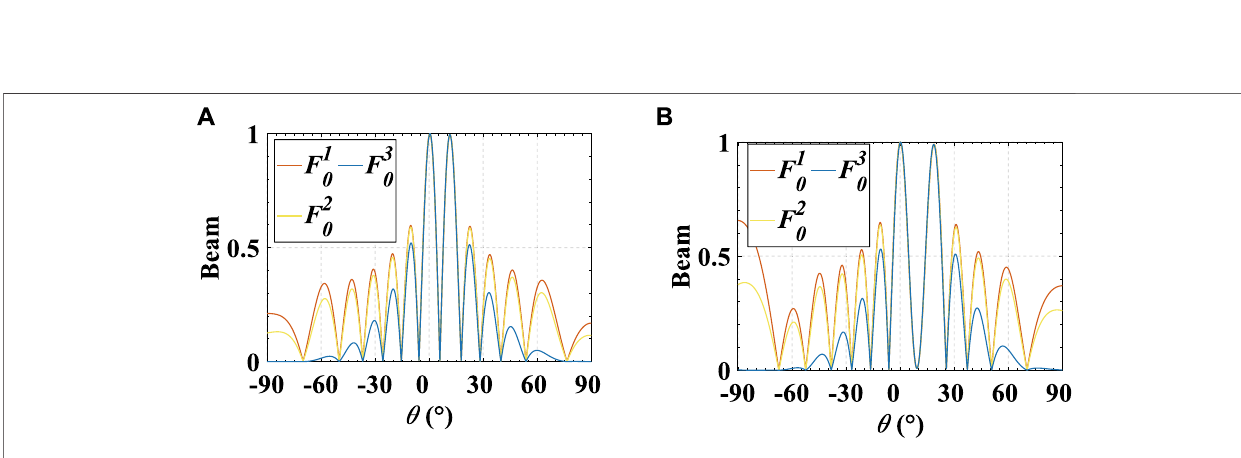
FIGURE 10 | Beampattern of the CFDAs with different antenna patterns. (A) Beampattern for ( r t , θ t , ϕ t ) (cid:1) ( 1 . 25 m , 0 ° , 0 ° ) ; (B) beampattern for ( r t , θ t , ϕ t ) (cid:1) ( 2 . 5 m , 0 ° , 0 ° ) .